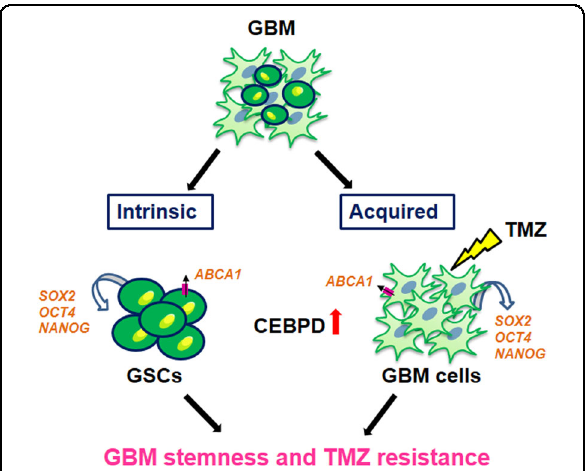
Fig. 7 A proposed model for the involvement of CEBPD in stemness and TMZ resistance in GBM. CEBPD can facilitate GSC formation and GBM resistance to TMZ by upregulating the SOX2, OCT4, NANOG, and ABCA1 expression through acquired and intrinsic